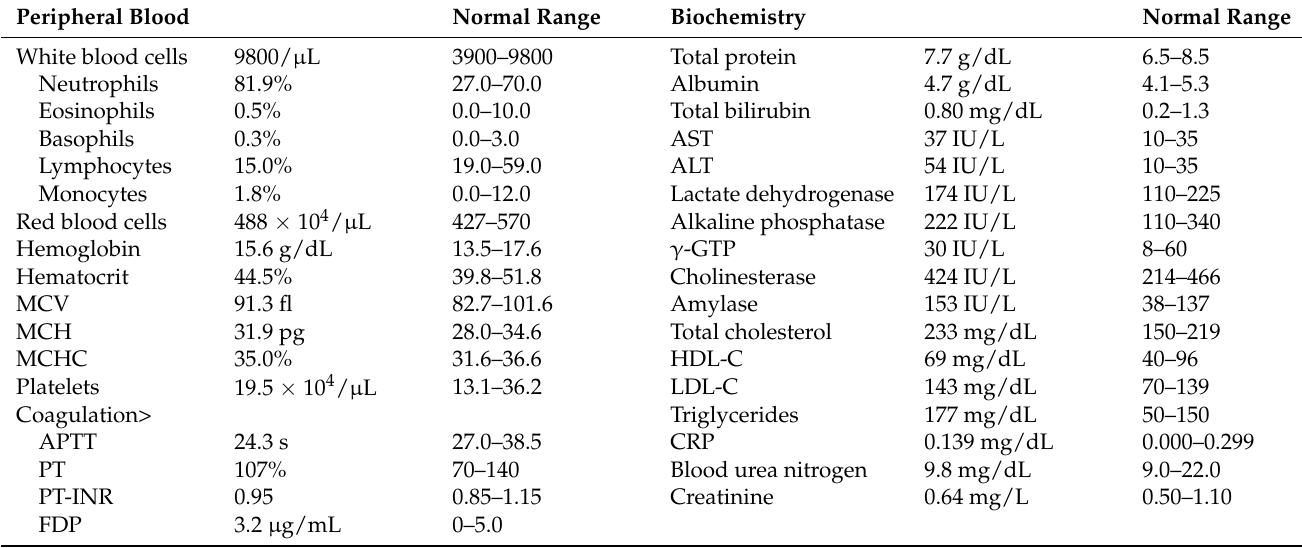
Table 1. Blood analysis